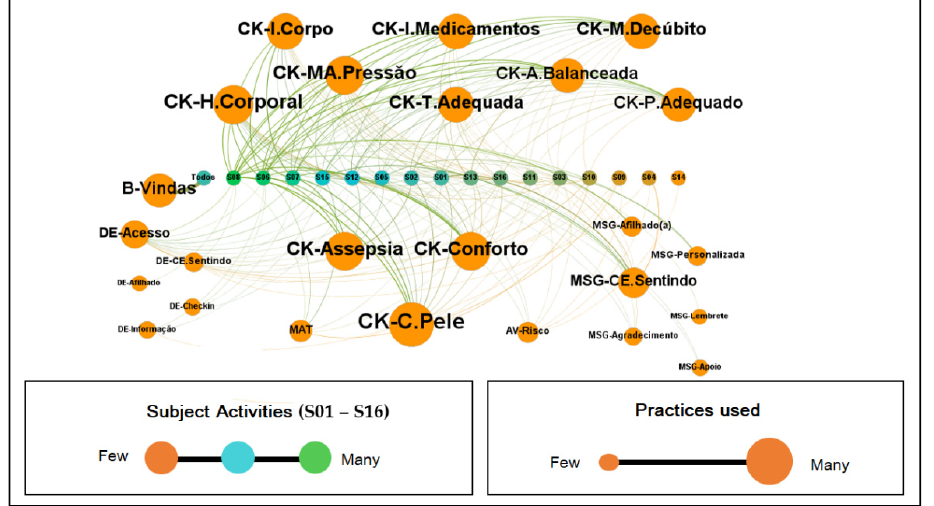
Figure 7. Graph of Subjects’ Interactions with ColaborAtiva.